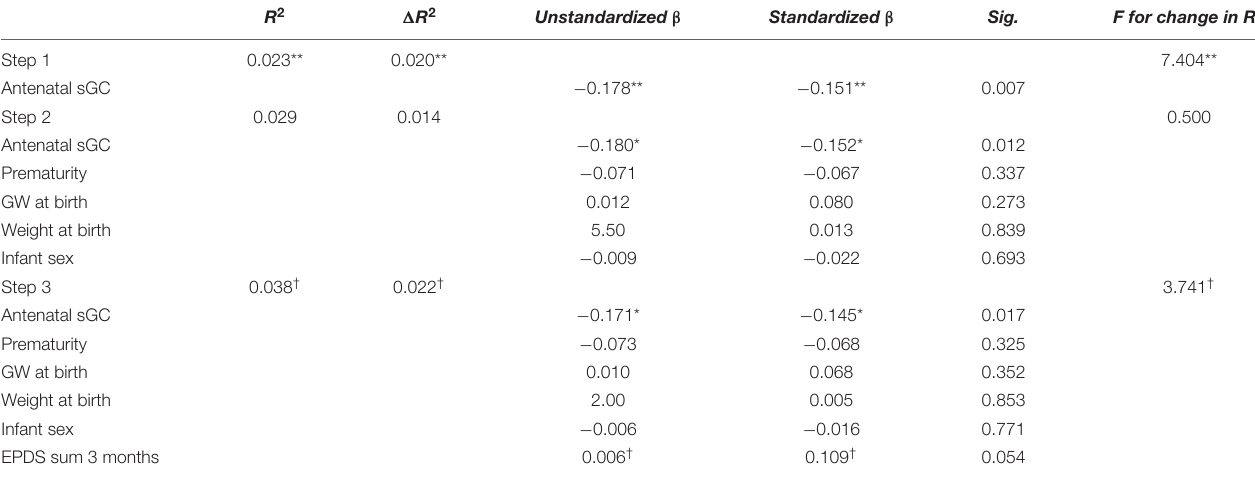
TABLE 3 | Hierarchical multiple regression for Fear bias for the whole sample. R 2 (cid:49) R 2 Unstandardized β Standardized β Sig. F for change in R